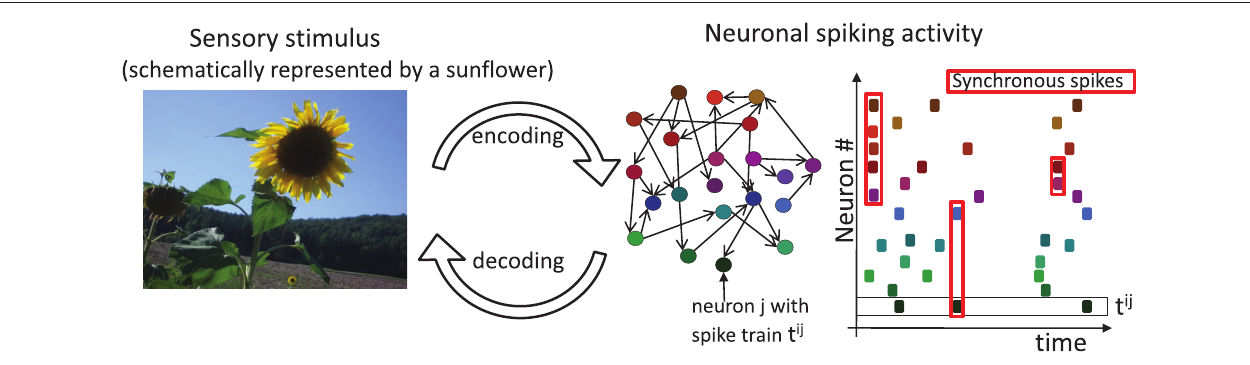
depicted as dots. A black square highlights the spike train t ij of neuron j and the red squares highlight examples of synchronous spikes. Sensory information is contained in the total number of spikes, their timing and the spike cross correlations between two or more neurons. Potential decoding strategies can benefit from any of these